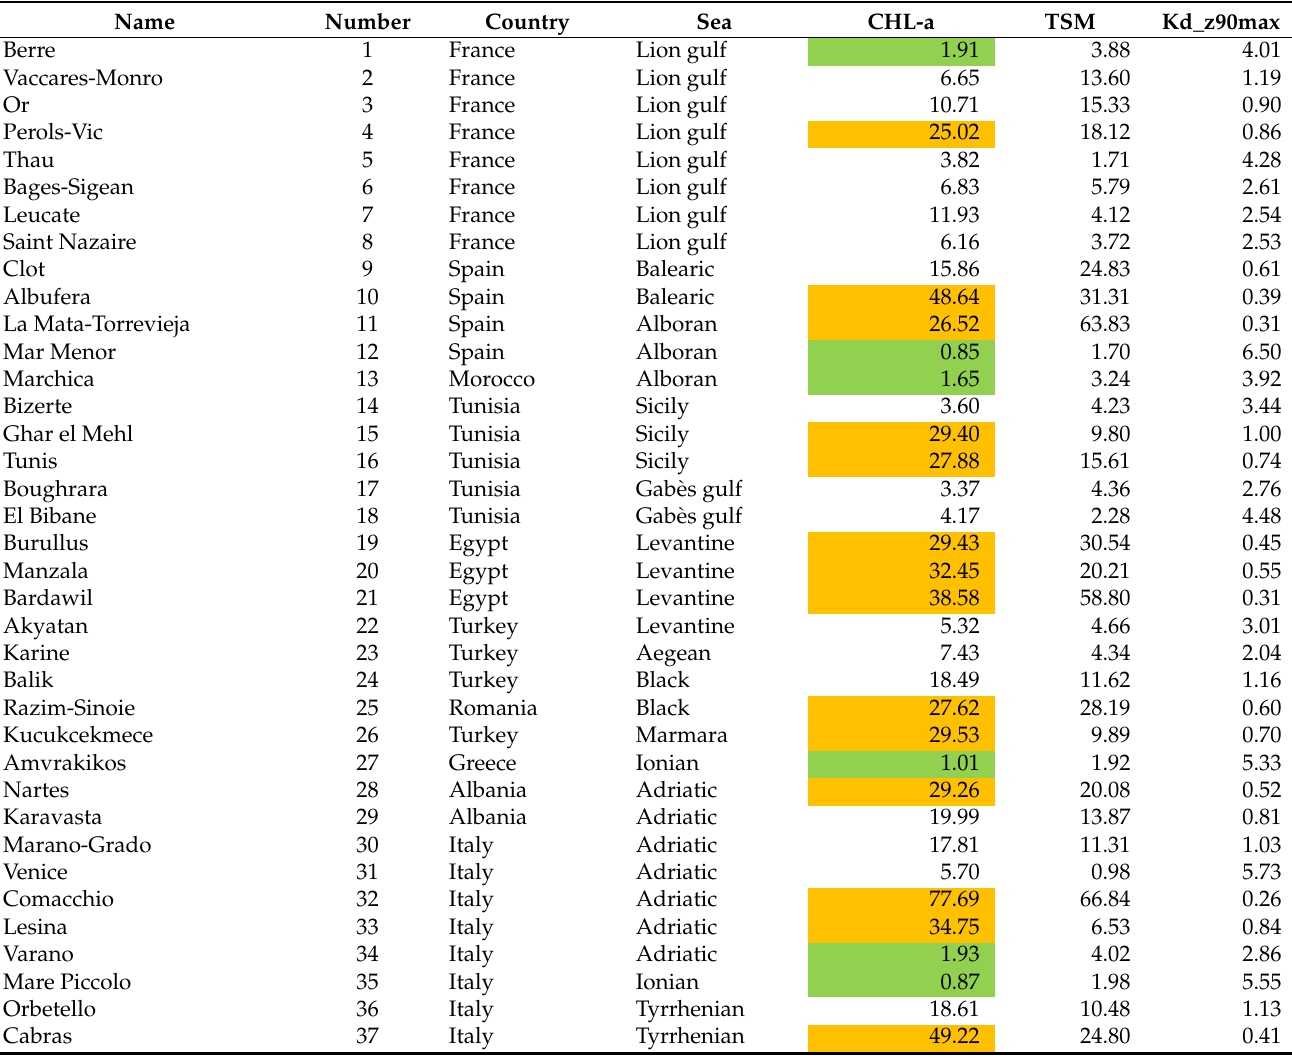
Table A1. Variables obtained by studying Sentinel-2 imagery in summer 2020. CHL-a, chlorophyll a (mg/m 3 ); TSM, total suspended matter (mg/L); Kd_z90max, water transparency measured as depth at which 10% of incident light reaches the surface (m). Highlighted in green, lagoons in better ecological status; in orange, lagoons in worse ecological